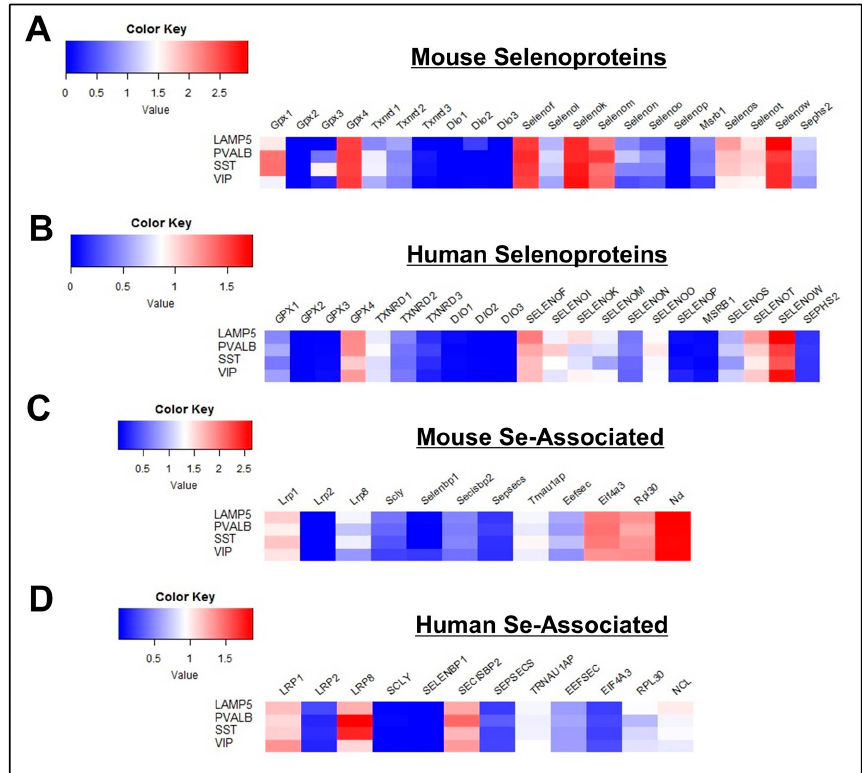
Figure 6. Profile of Se-related transcriptome in GABAergic neurons. ( A, B ) Heatmaps detailing expression of mouse ( A ) and human ( B ) selenoprotein genes in LAMP5+, PVALB+, SST+, and VIP+ GABAergic neurons. ( C, D) Corresponding heatmaps of mouse ( C ) and human ( D ) Se-associated genes.